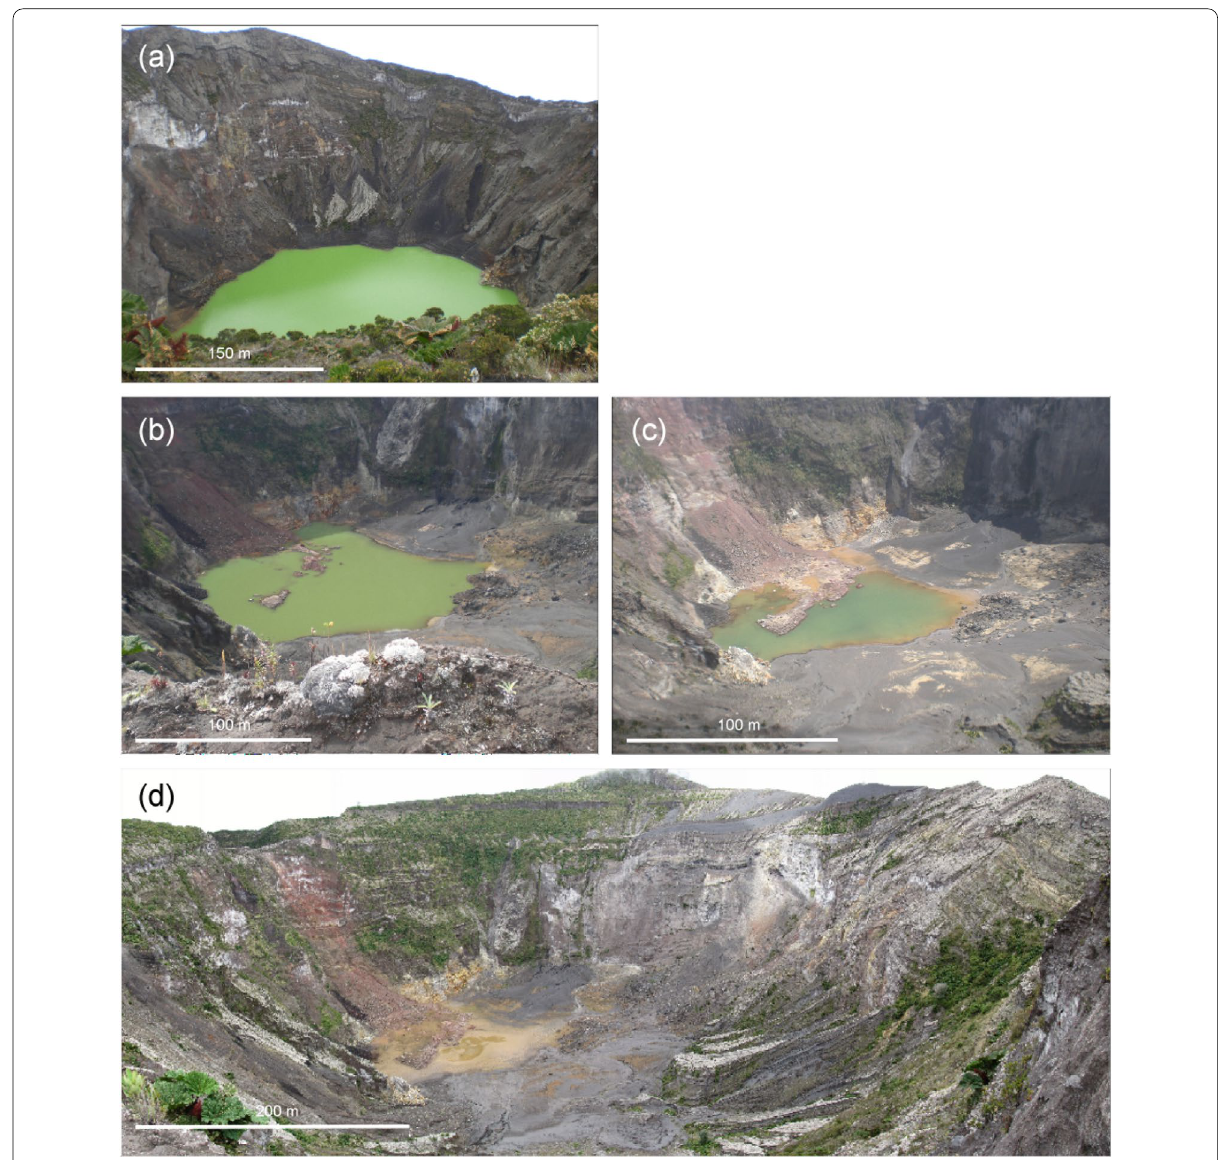
Fig. 2 View of the summit crater lake within the “Cráter Activo” of Irazú in April 2007 ( a from the south), December 2009 ( b from the north), March 2010 ( c from the north), and May 2010 (d, from the north), showing a progressive reduction of the lake level. Pictures by D. Rouwet ( a , b , c ) and R. Mora‑Amador ( d